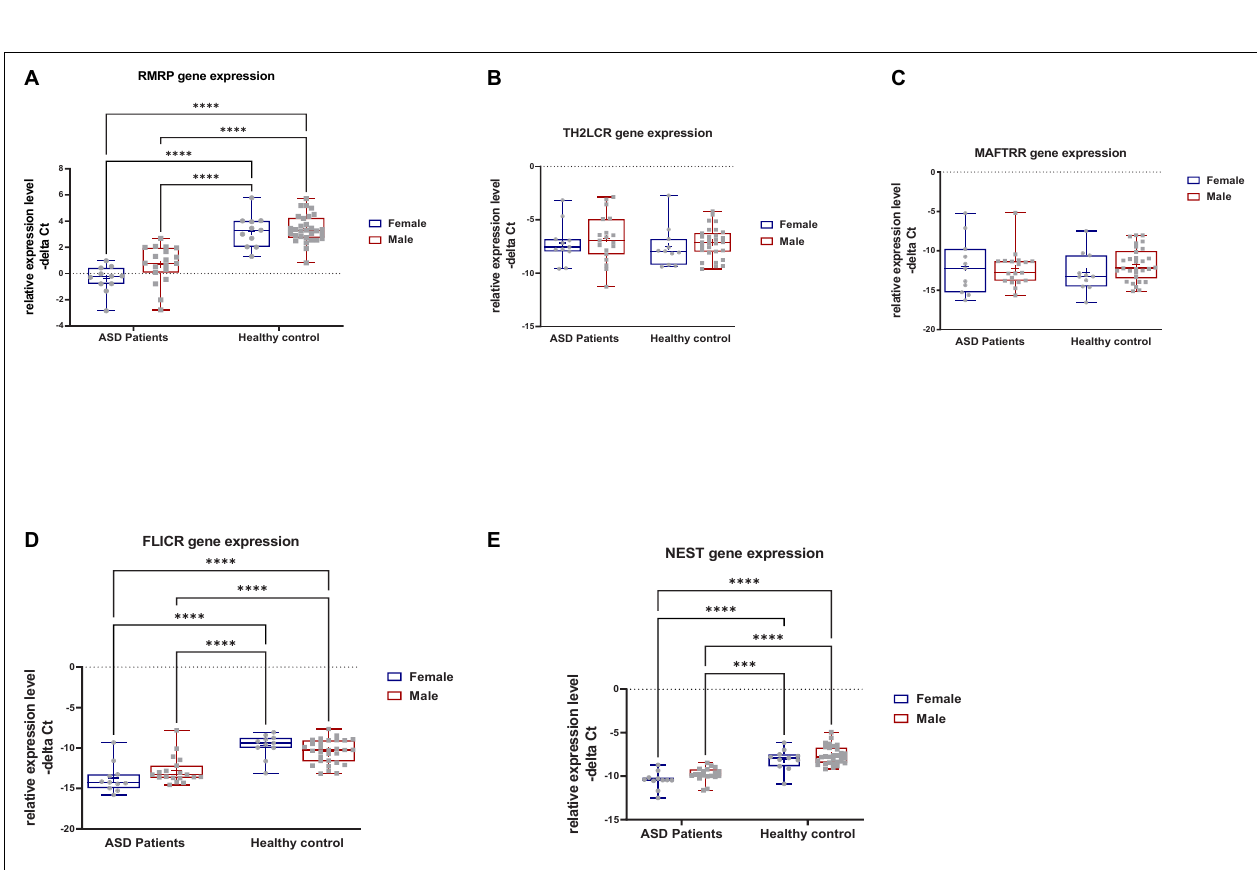
FIGURE 2 | Relative expression levels of five Treg-related genes in subgroups of patients with ASD vs. control subgroups as described by –delta Ct values. –Delta Ct data is plotted. Median, mean, and interquartile ranges are shown. The effects of disease and gender on the expression of lncRNAs were appraised using two-way ANOVA and Tukey post hoc tests ( ∗∗∗∗ P -value < 0.0001; ns, non-significant).